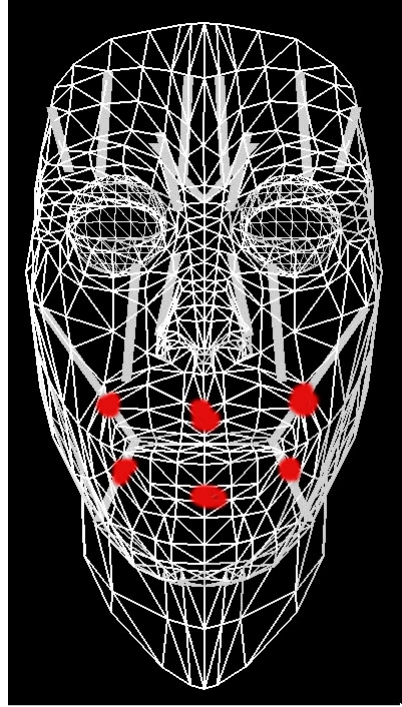
Figure 8. Muscles on the talking